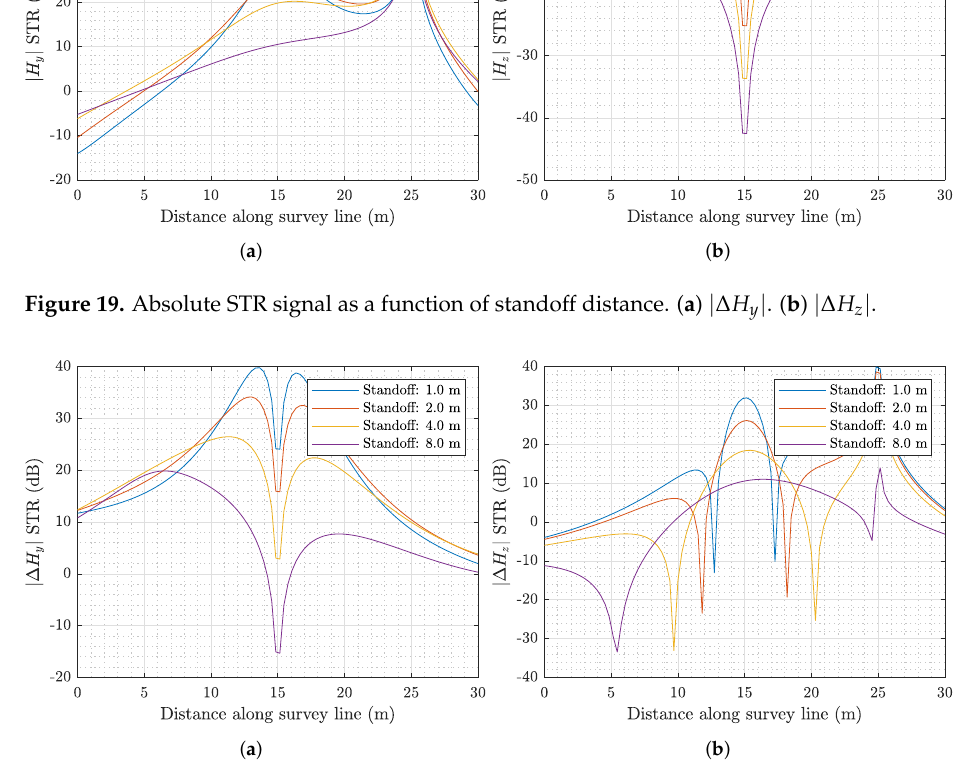
Figure 20. Gradiometer (difference) STR signal as a function of standoff distance. ( a ) | ∆ H y | . ( b ) | ∆ H z |